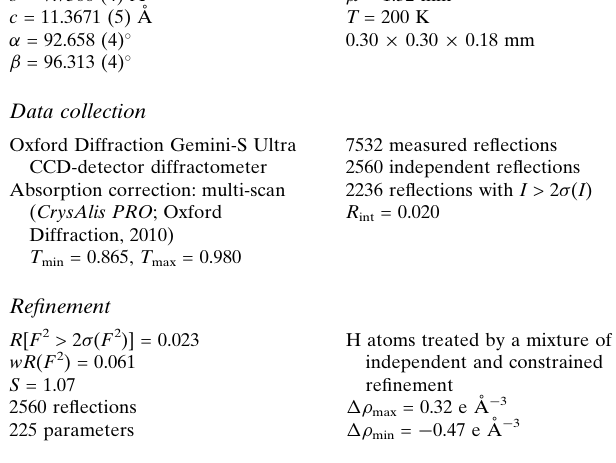
Oxford Diffraction Gemini-S Ultra CCD-detector diffractometer Absorption correction: multi-scan ( CrysAlis PRO ; Oxford Diffraction, 2010) T min = 0.865, T max = 0.980